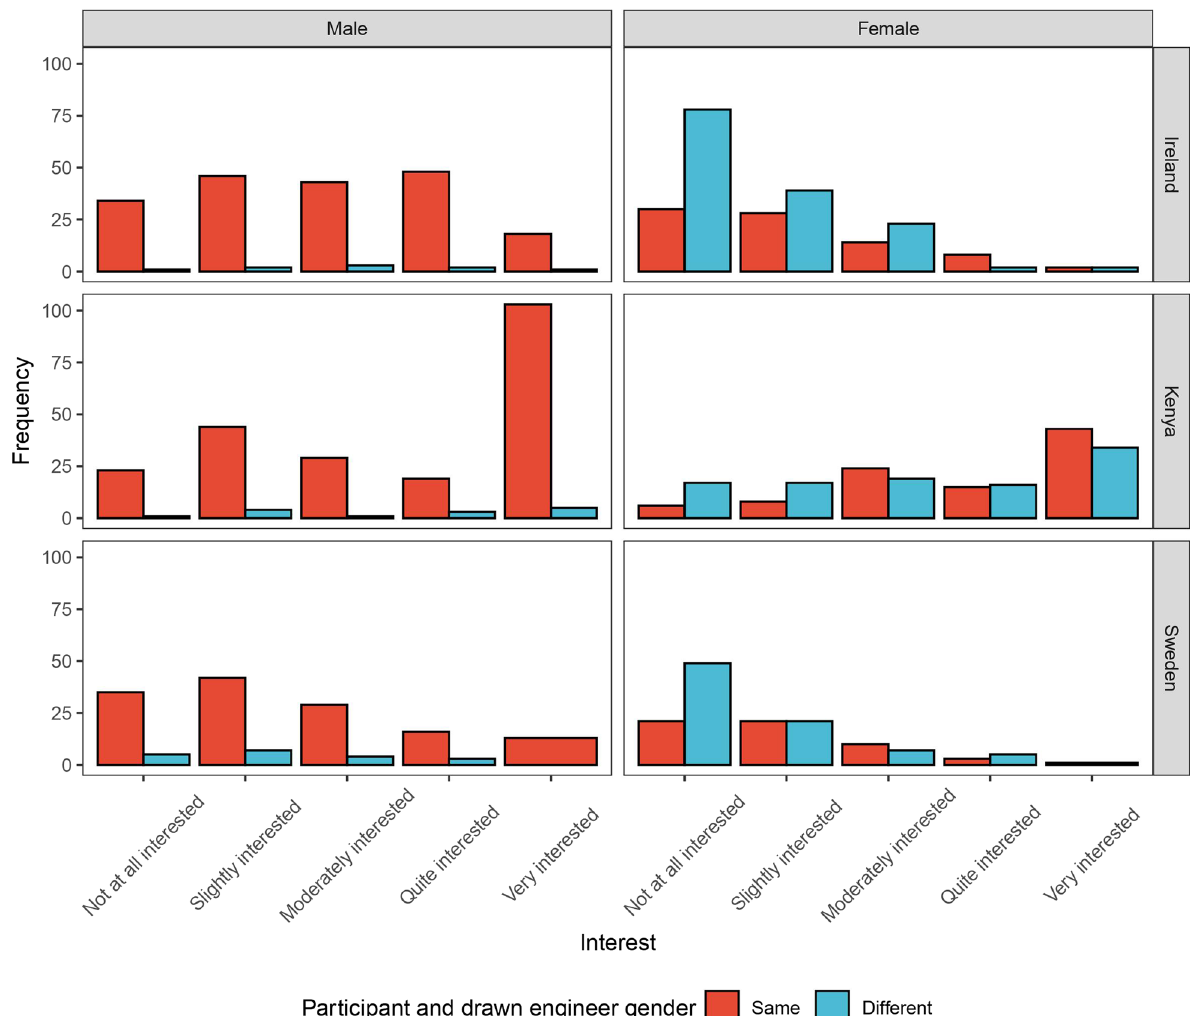
Fig. 5 Comparison of students’ self-reported gender and gender of drawn engineers (same or different) across levels of reported interest in becoming an